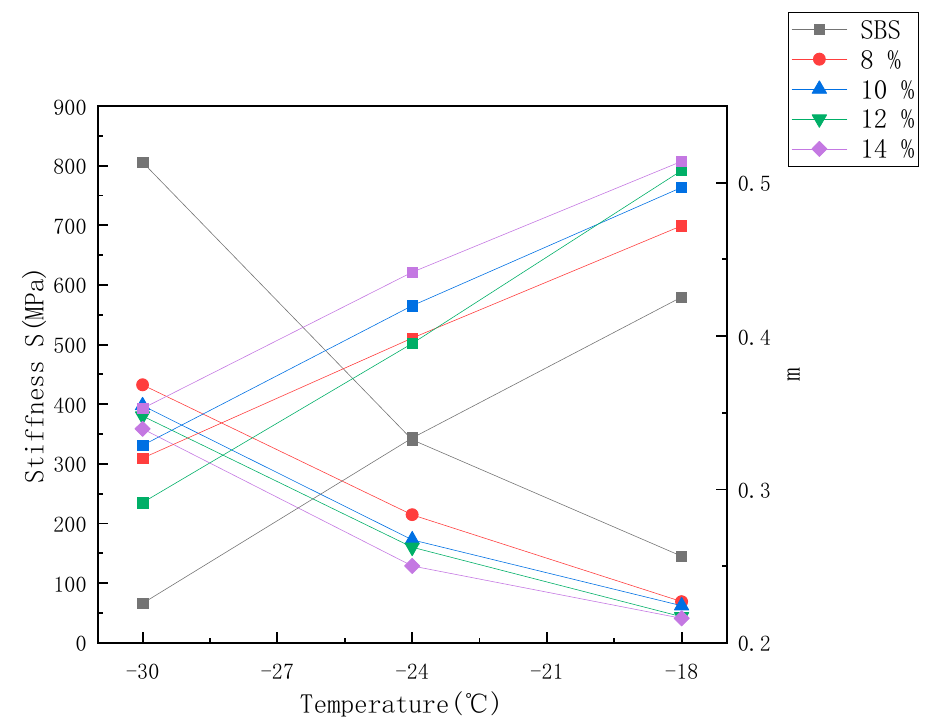
Figure 5. Curves of creep stiffness S and creep rate m of SBS and SMCSBS with different content with temperature.